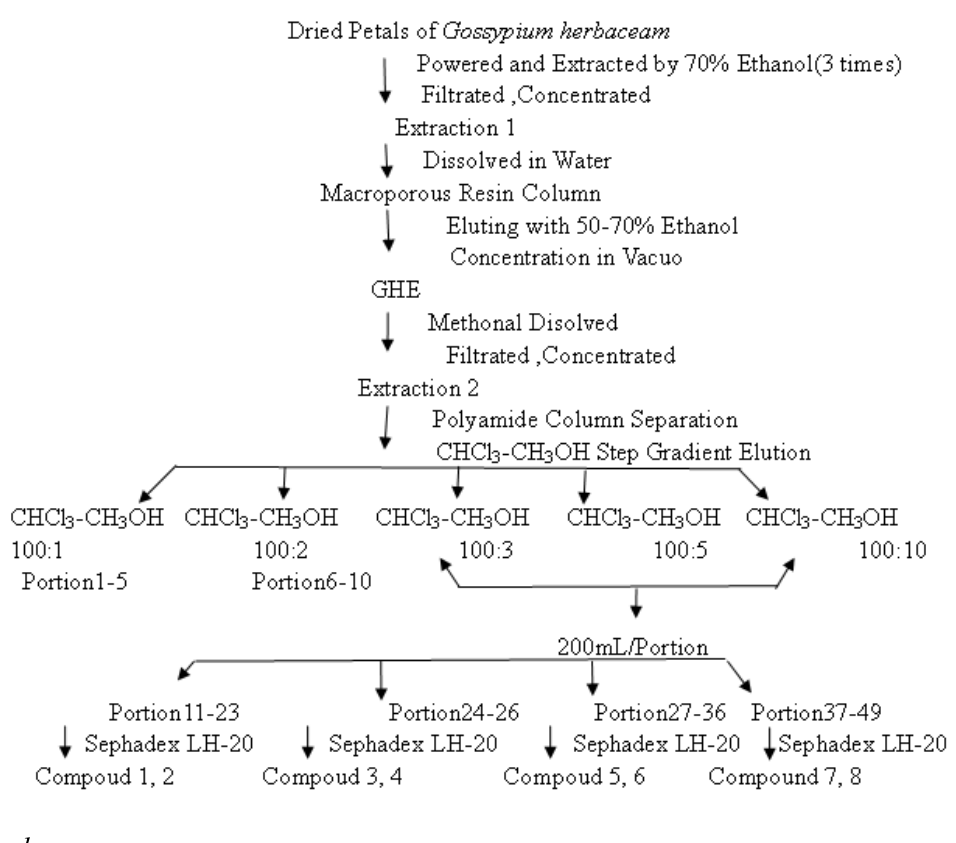
Figure 4. The extraction and fractionations of Gossypium herbaceam